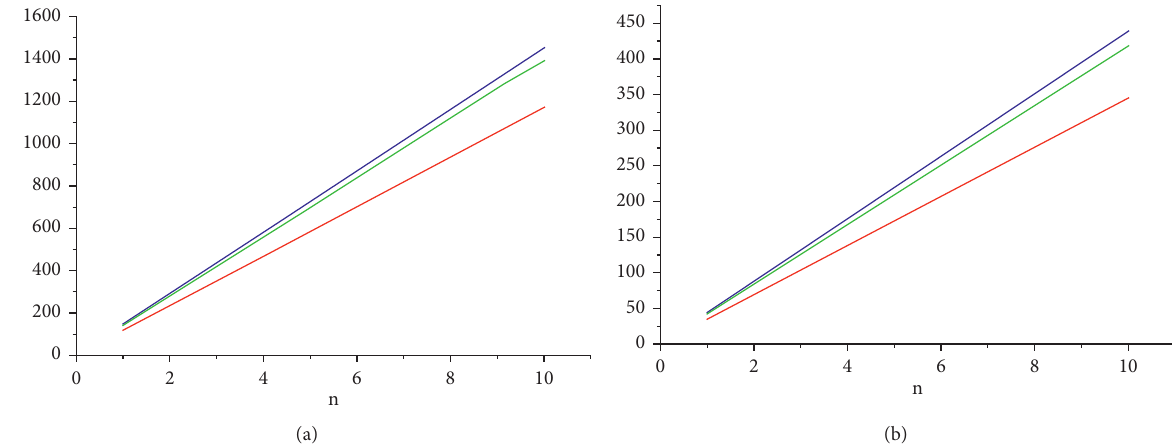
Figure 10: Comparison of SO and SS indices of guar gum, HPG and CMG, and CMHPG (a) SO (guar gum) in red, SO (HPG and CMG) in green, and SO (CMHPG) in blue; (b) SS (guar gum) in red, SS (HPG and CMG) in green, and SS (CMHPG) in